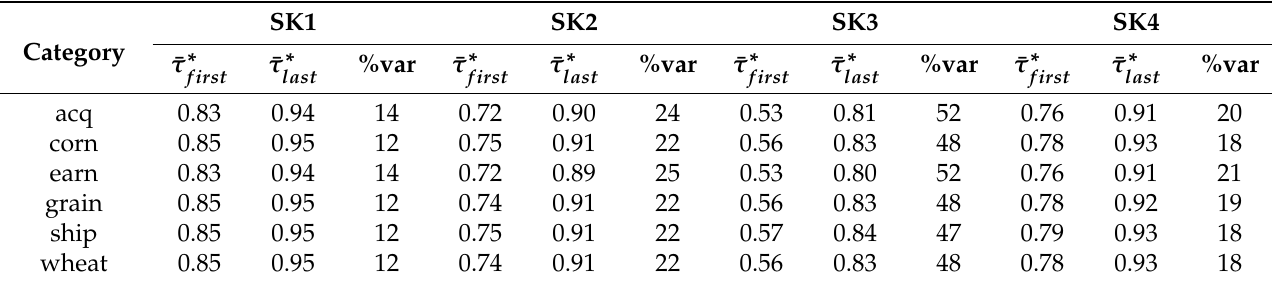
Table A3. Average of the computed collective concordance indices per category ( m = 5).